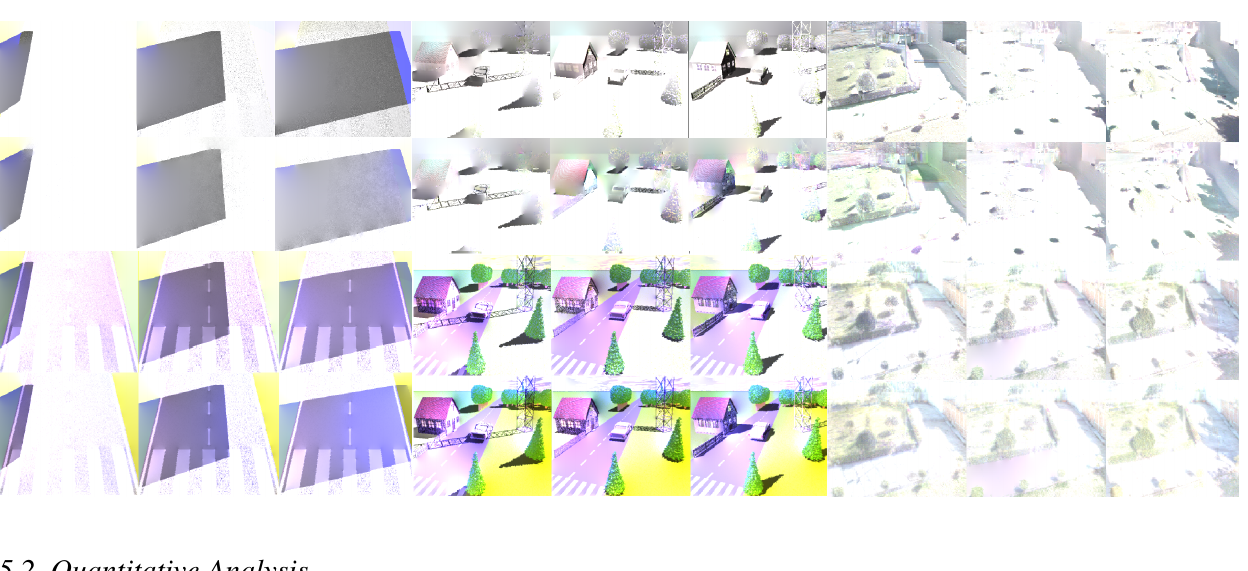
Figure 4. Corresponding illumination images of Figure 2. From top to bottom: Weiss [19], Matsushita et al. [20], gray [39], and color Retinex Methods